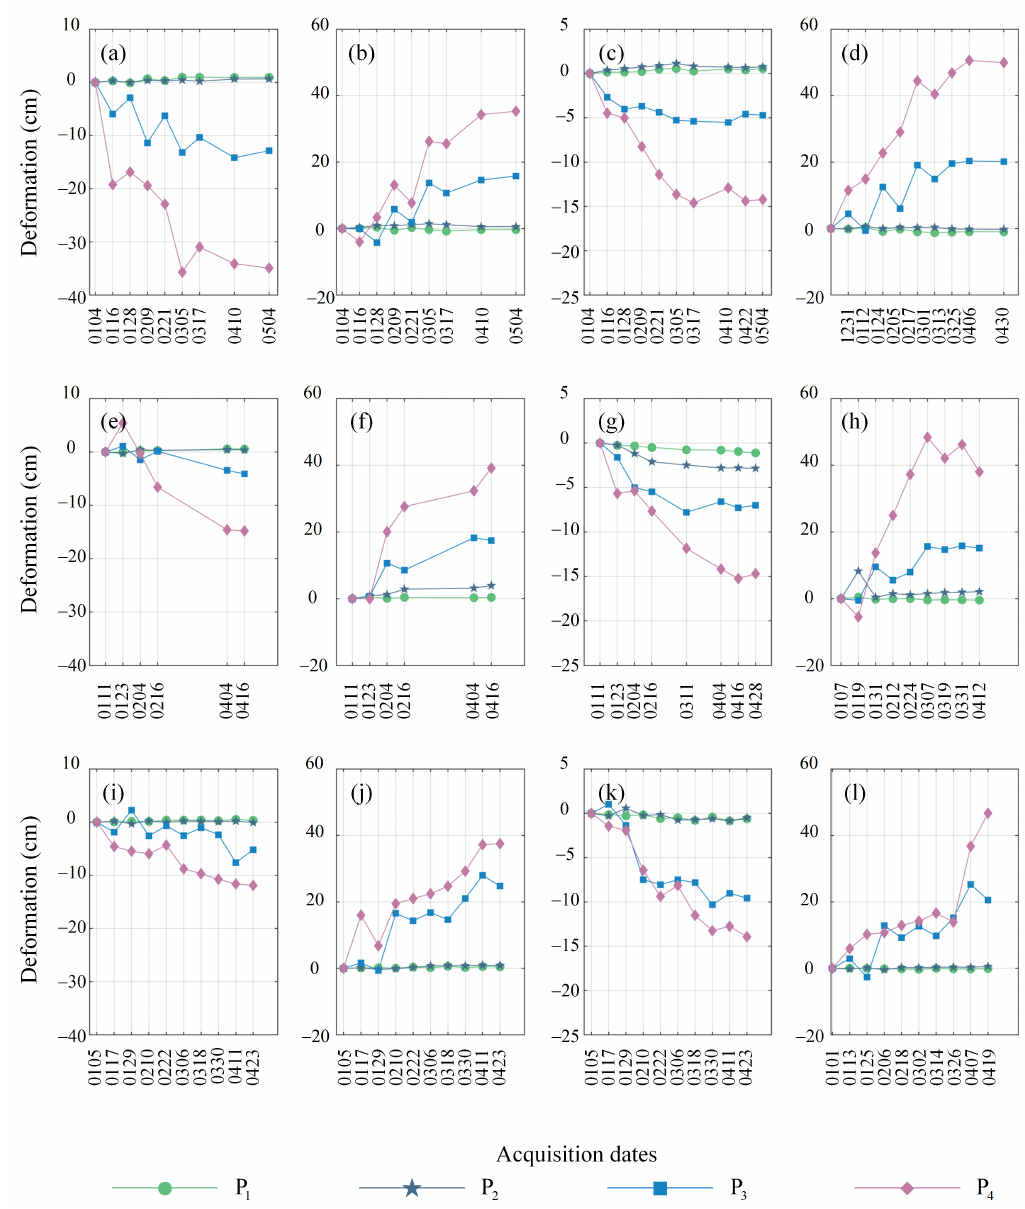
Figure 5. Cumulative deformation from different directions of each feature point: ( a ) vertical deformation in 2019; ( b ) horizontal deformation in 2019; ( c ) ascending LOS deformation in 2019; ( d ) descending LOS deformation in 2019; ( e ) vertical deformation in 2020; ( f ) horizontal deformation in 2020; ( g ) ascending LOS deformation in 2020; ( h ) descending LOS deformation in 2020,; ( i ) vertical deformation in 2021; ( j ) horizontal deformation in 2021; ( k ) ascending LOS deformation in 2021; ( l ) descending LOS deformation in